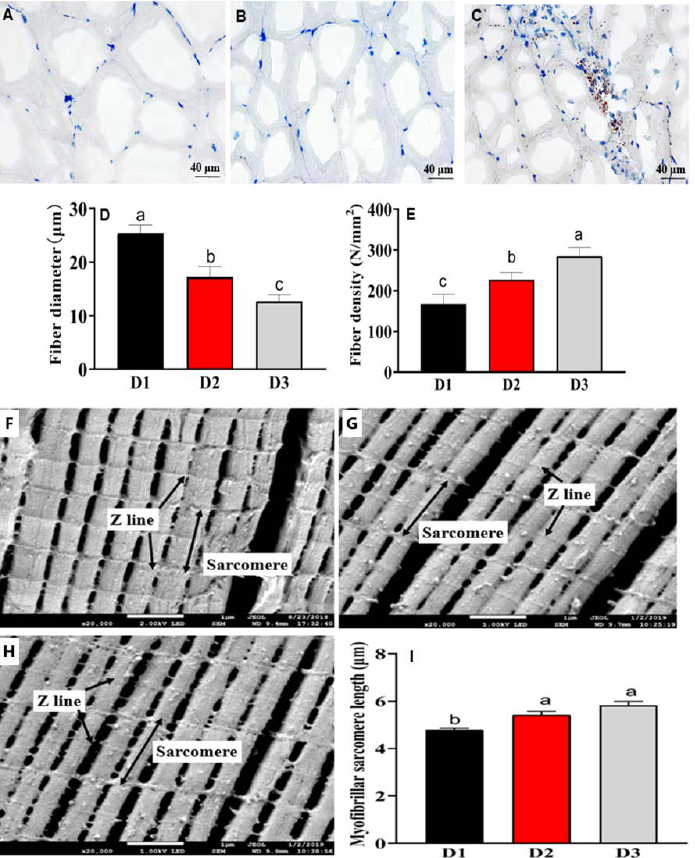
Figure 1. Transverse section microstructure and transmission electron microscope of muscle in common carp fed experimental diets. Transverse section microstructure ( A – C ): oil-red O staining, × 400, scale bar 40 µ m. ( A ) D1 diet treatment group; ( B ) D2 diet treatment group; ( C ) D3 diet treatment group; ( D ) myofiber diameter of common carp; ( E ) myofiber density of common carp. Transmission electron microscope: ( F – H ): photomicrographs ( × 20,000) and scale bar (1 µ m). The lines with bidirectional arrows indicated the sarcomere lengths. The lines with an unfilled arrow indicated the Z line. ( F ) D1 diet treatment group; ( G ) D2 diet treatment group; ( H ) D3 diet treatment group; ( I ) myofibrillar sarcomere length of common carp. Values are expressed as means ± SEM ( n = 3). Bars among each group with different letters indicated significant differences ( p <